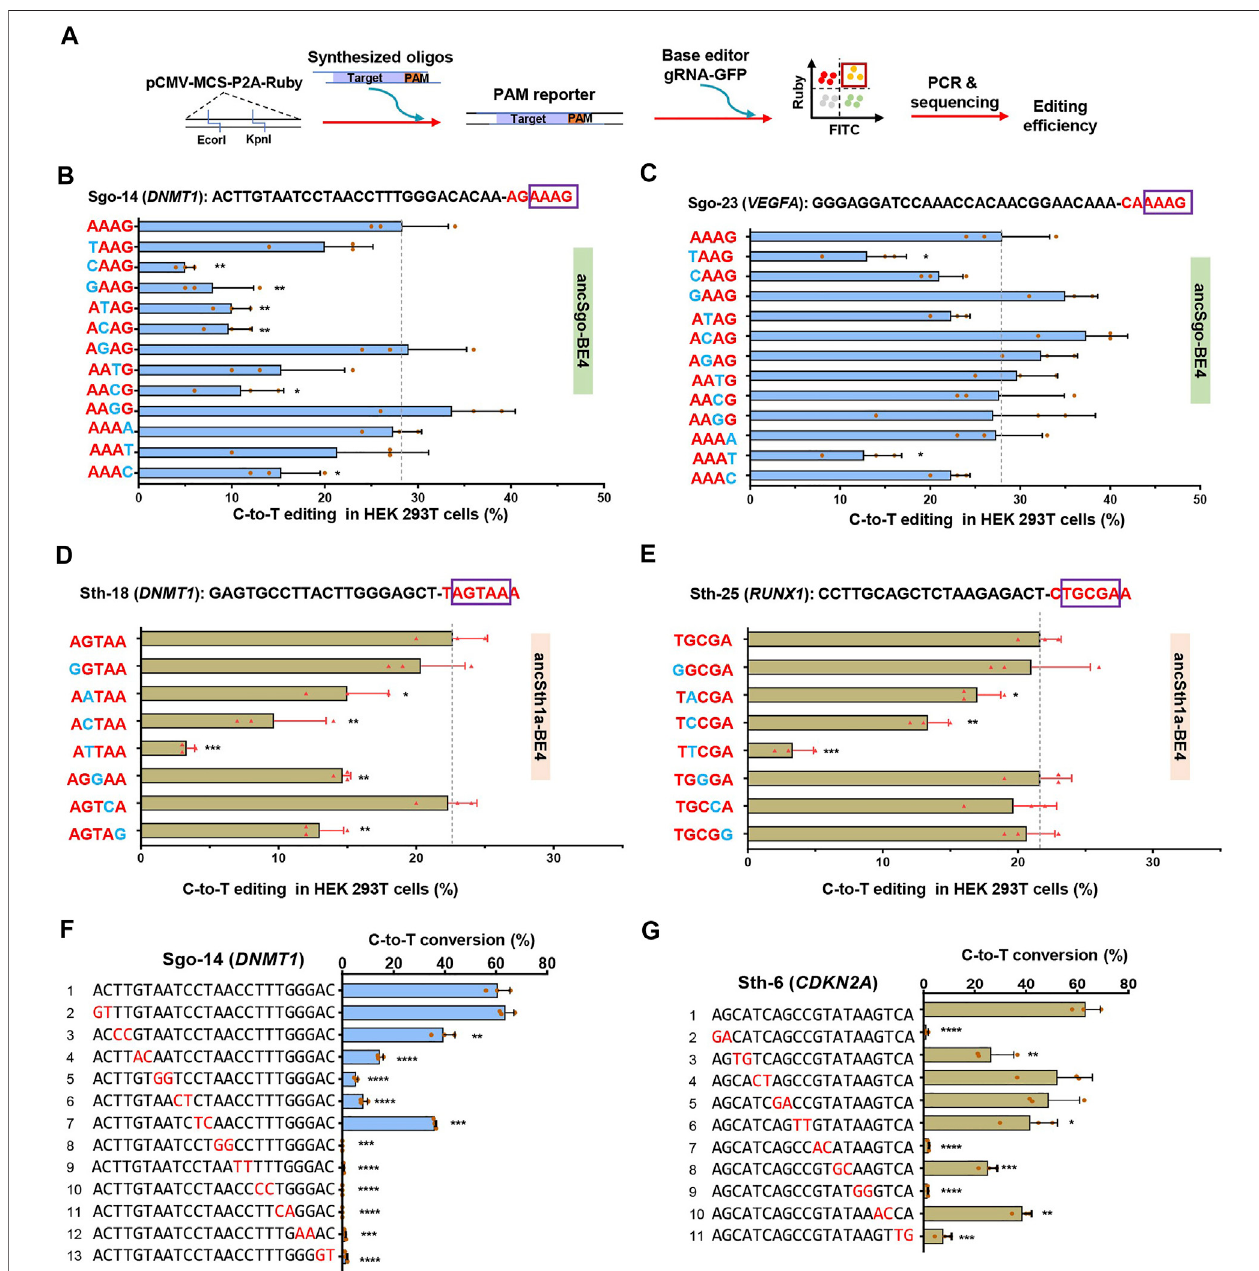
FIGURE5| Analysisofeditingspeci fi citywith mismatches within PAMortargetsequences. (A) Schematicofstrategyfor constructing PAMreporterand work fl ow for testing the effects of PAM mismatches on editing ef fi ciencies. (B,C) C-to-T editing ef fi ciencies induced by ancSgo-BE4 in HEK293T cells were presented when ancSgo-BE4 and gRNAs targeting DNMT1 site Sgo-14 (B) and VEGFA site Sgo-23 (C) were co-transfected with PAM reporters with indicated mismatches (in blue). (D,E) C-to-Teditingef fi cienciesinducedbyancSth1a-BE4inHEK293TcellswerepresentedwhenancSth1a-BE4andgRNAstargeting DNMT1 siteSth-1 (D) and RUNX1 site Sth1a-25 (E) were co-transfected with PAM reporters with indicated mismatches (in blue). (F,G) Data showing the C-to-T editing ef fi ciencies induced by ancSgo-BE4 (F) or ancSth1a-BE4 (G) when targeting Sgo-14 or Sth1a-6 with gRNAs constructed with two dinucleotide mismatches (highlighted in red). All editing ef fi ciencies in this fi gure were calculated from target deep sequencing data (Student ’ s t -test). * p < 0.05, ** p < 0.01, *** p < 0.001, **** p < 0.0001.